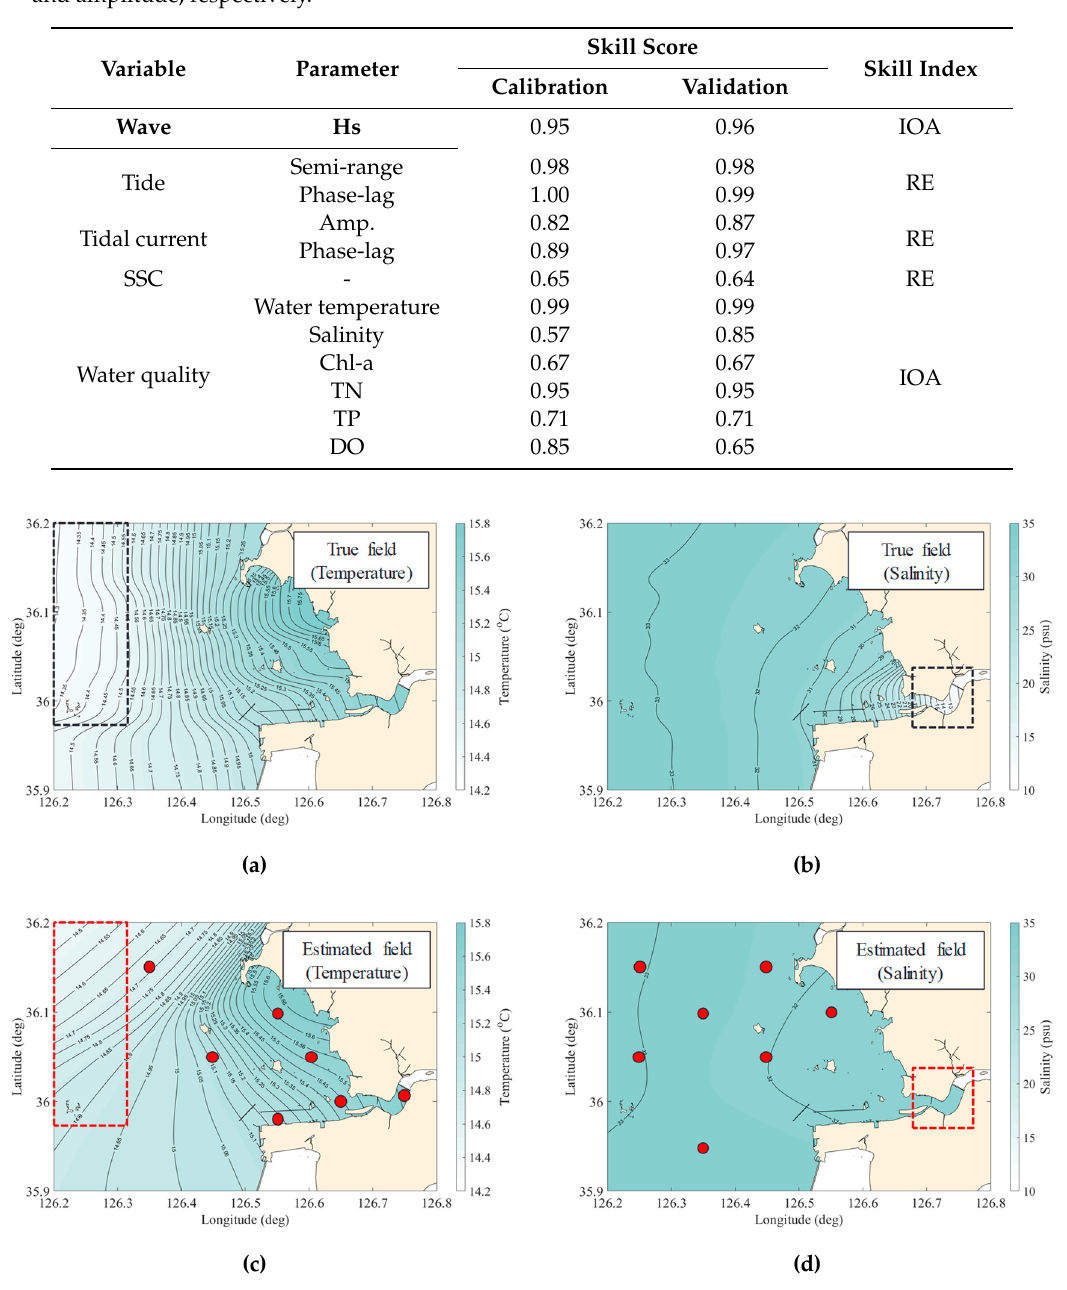
Figure A1. The true field of ( a ) water temperature and ( b ) salinity, and the example of the monitoring array ( c ) designed by considering only salinity and reconstructing the spatial distribution of the water temperature, and ( d ) designed by considering only water temperature and reconstructing the spatial distribution of the salinity.